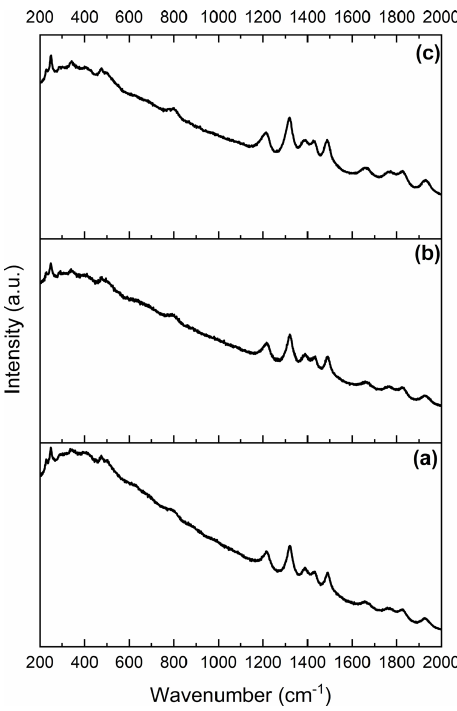
Figure 4. Raman scattering of glass-ceramics obtained from Ca Glass treated at 960 ºC during (a) 2 hs, (b) 4 hs and (c) 6 hs.